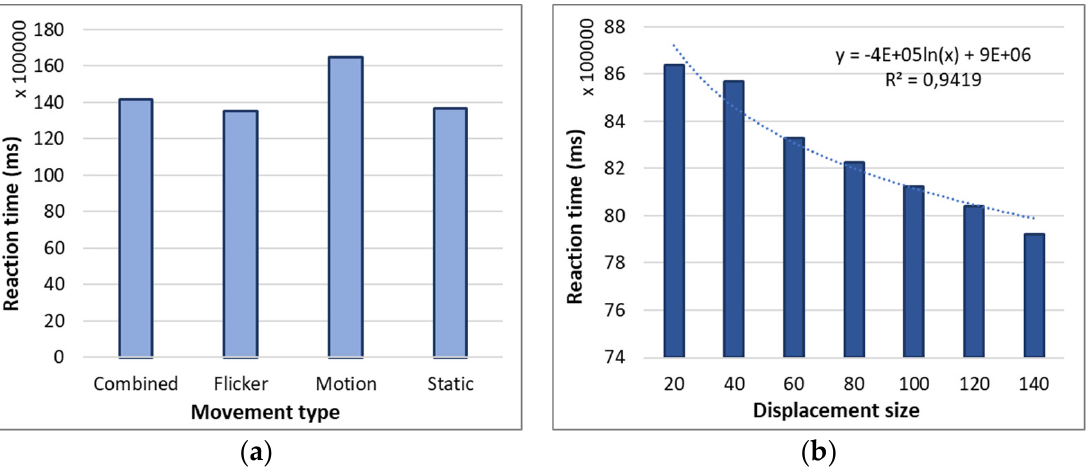
Figure 12. ( a ) Influence of the type of motion of the stimuli on the total decision time of the participants in the experiment. ( b ) Influence of the size of displacement from the center of the set of dots on the total decision time of the participants in the experiment.